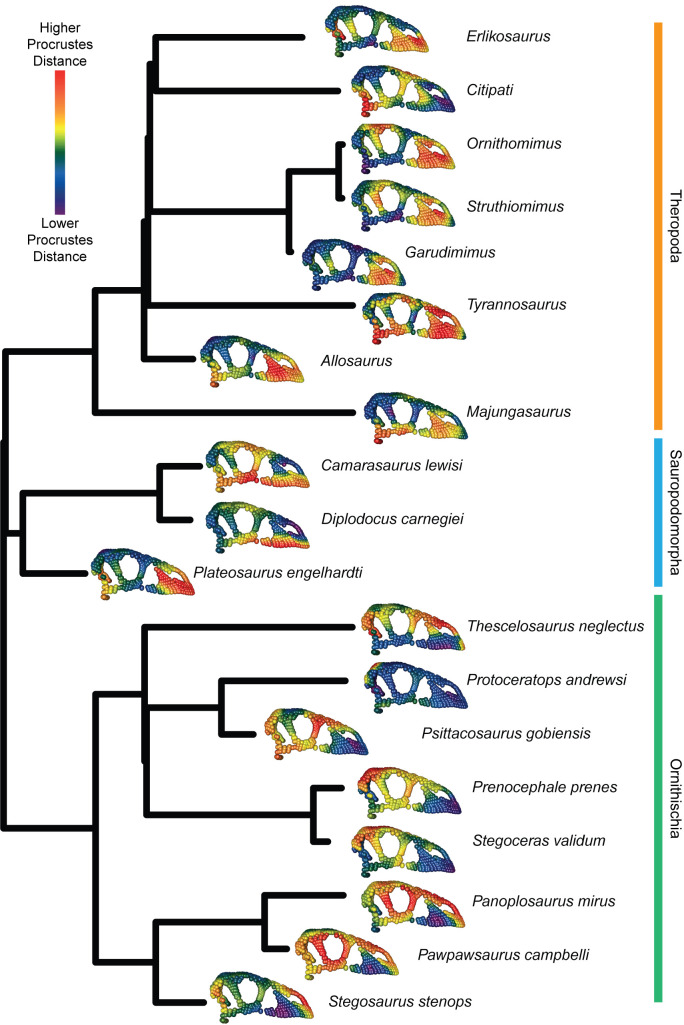
Phenotypic difference between each specimen for each landmark in the 11-module dataset and the mean skull shape.For each specimen, the mean landmark configuration is plotted with points coloured relative to the Procrustes distance between the position of that point in the mean shape and in that specimen. Warmer colours denote landmarks having higher displacement from the mean, and cooler colours are more similar to the mean shape. Data and code archived at www.github.com/rnfelice/Dinosaur_Skulls.